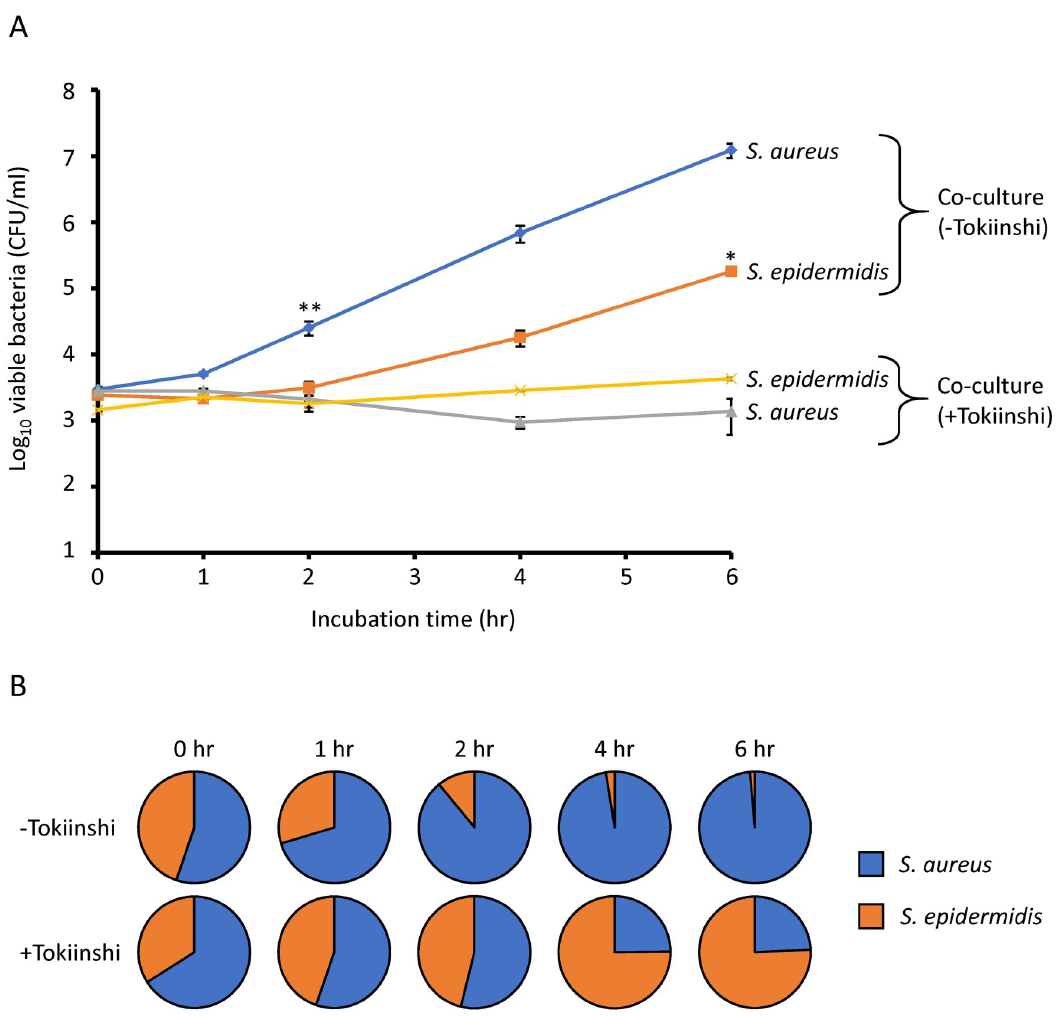
Fig 2. Growth inhibition effect of Tokiinshi (20 mg/ml) against co-culture of S . aureus and S . epidermidis . A, Growth curve of S . aureus and S . epidermidis in the co-culture. B, Survival ratio of S . aureus and S . epidermidis in the co-culture. � P < 0.05, in the presence of Tokiinshi, �� P < 0.01, in the presence of